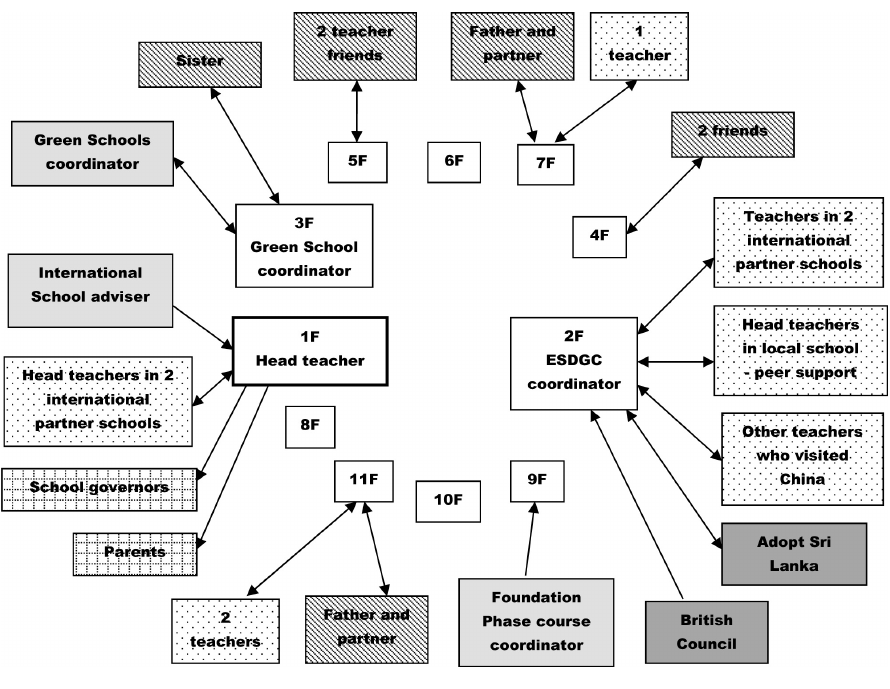
Figure 1c: Faban teachers’ external networks